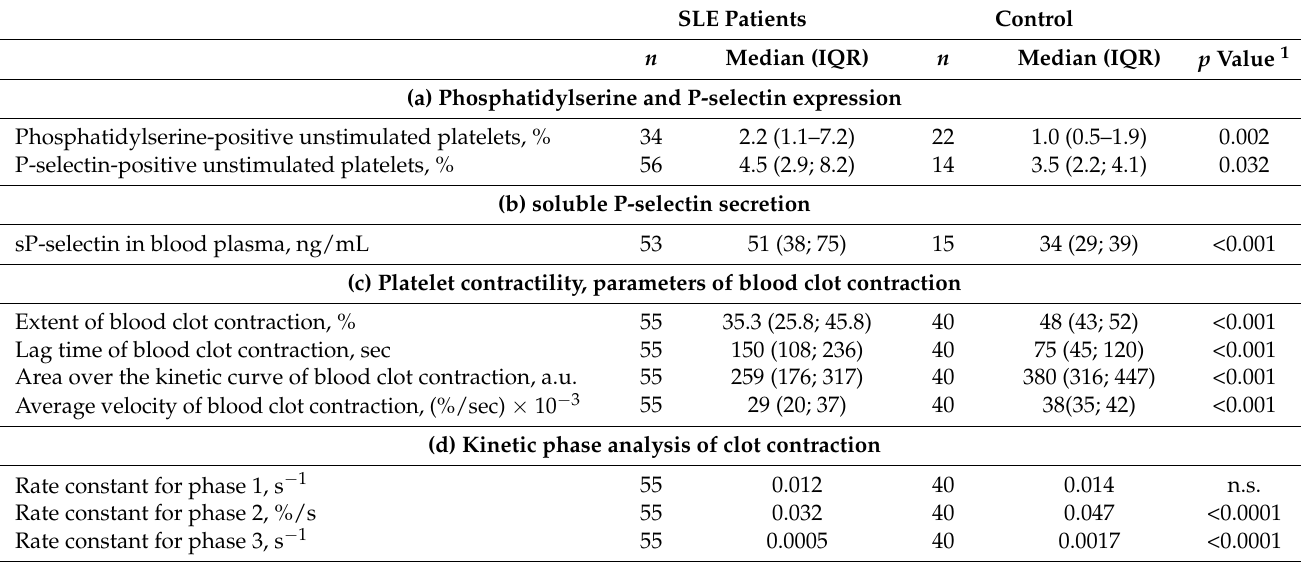
Table 1. Fraction of platelets with background expression of phosphatidylserine or P-selectin ( a ), levels of sP-selectin ( b ), and parameters of clot contraction kinetics ( c , d ) in clots made from the blood of SLE patients and healthy